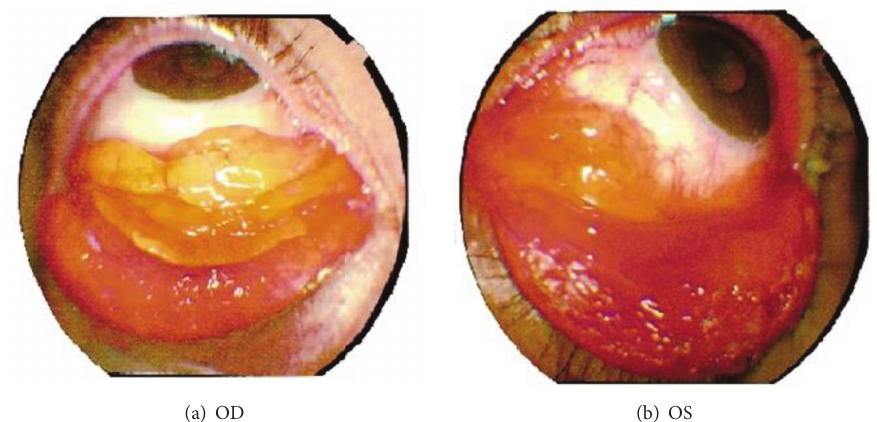
Figure 1: External photos of right (a) and left (b) eye showing bilateral yellow-pink conjunctival mass in the lower fornices with subconjunctival hemorrhage and left eye ectropion.